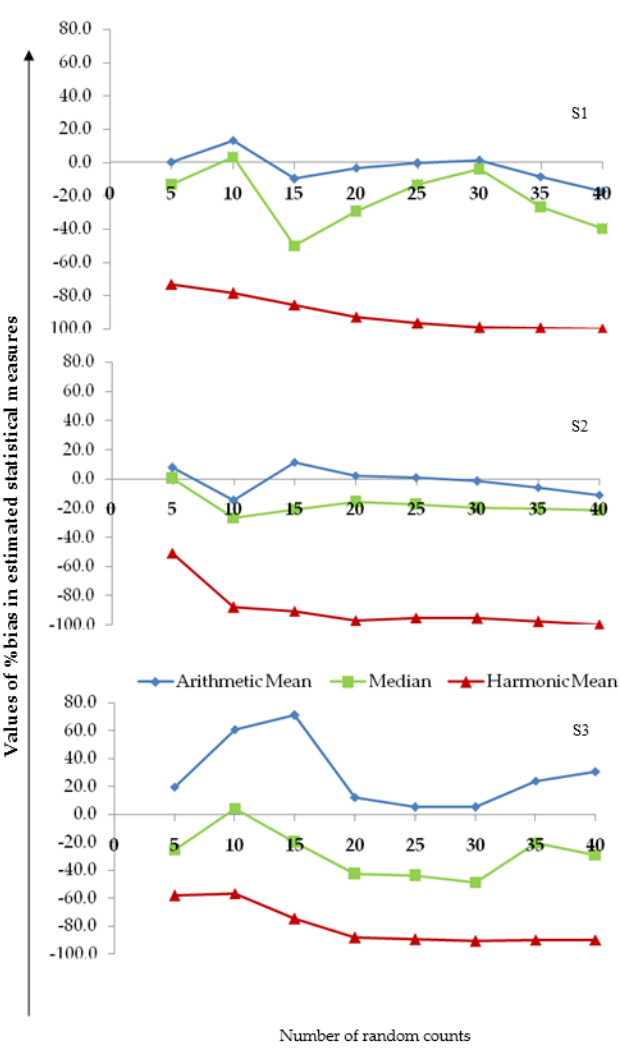
Figure 6. The percentage bias for each of the samples S1, S2 and S3 associated with the estimated values of the arithmetic mean, median and harmonic mean based on the random counts generated by bootstrapping (1000 iterations with replacement).